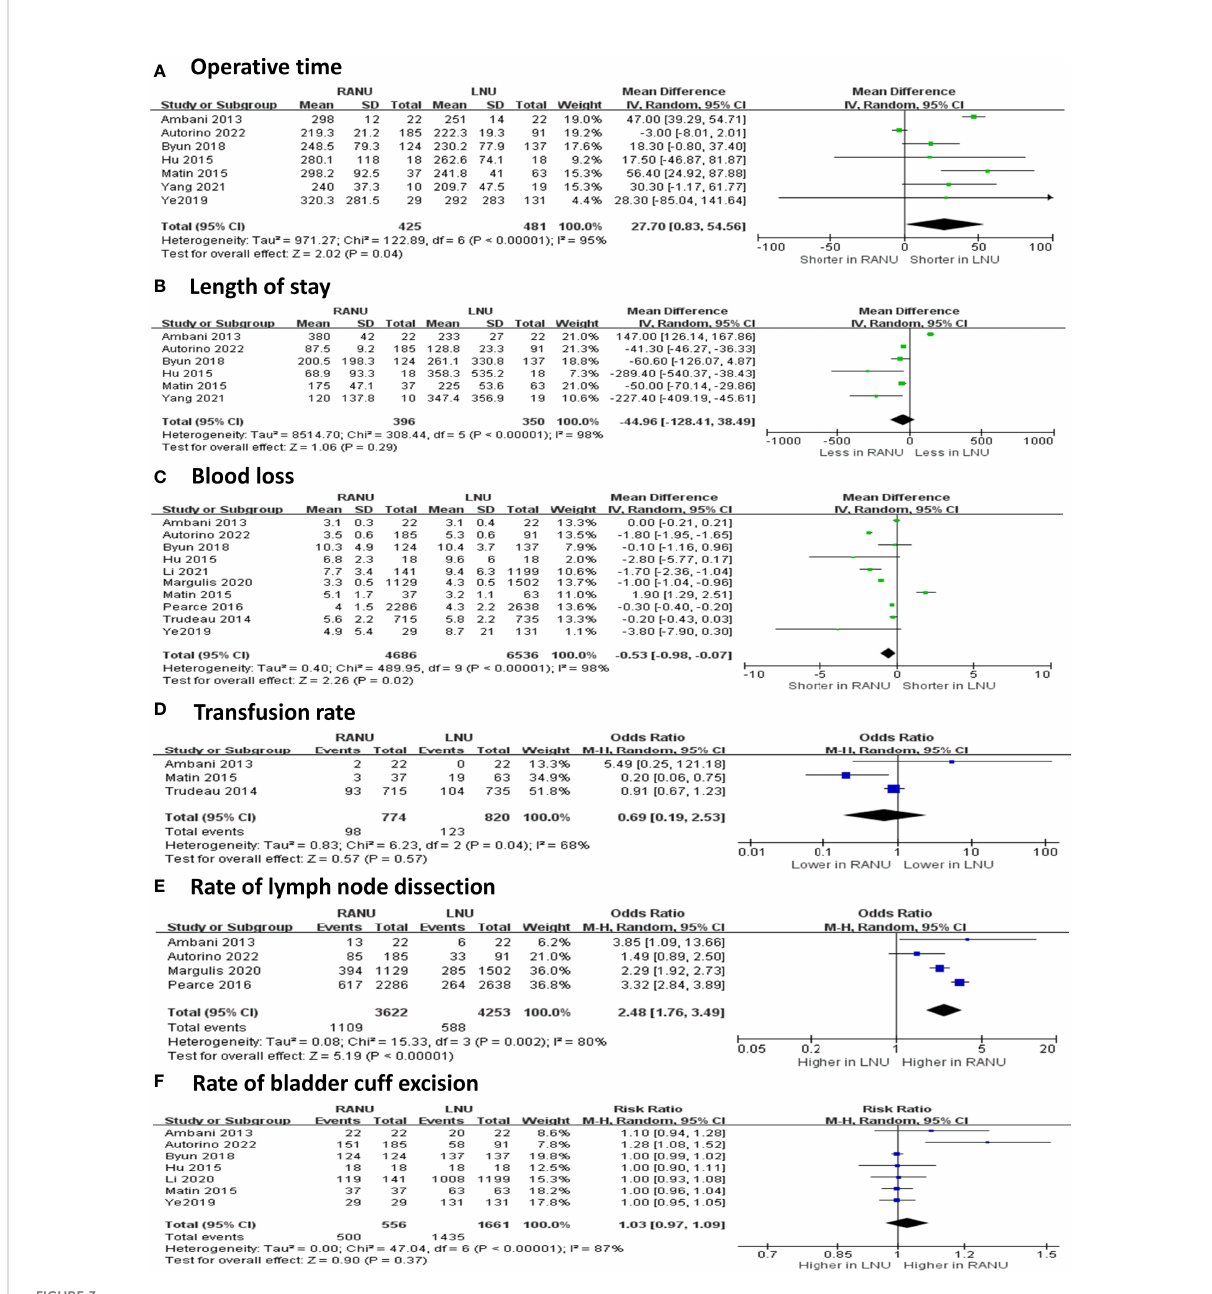
FIGURE 3 Forest plots of perioperative effectiveness outcomes including operative time (A) , blood loss (B) , length of stay (C) , transfusion rate (D) , rate of lymph node dissection (E) and rate of bladder cuff excision (F) for robotic-assisted nephroureterectomy (RANU) versus laparoscopic nephroureterectomy